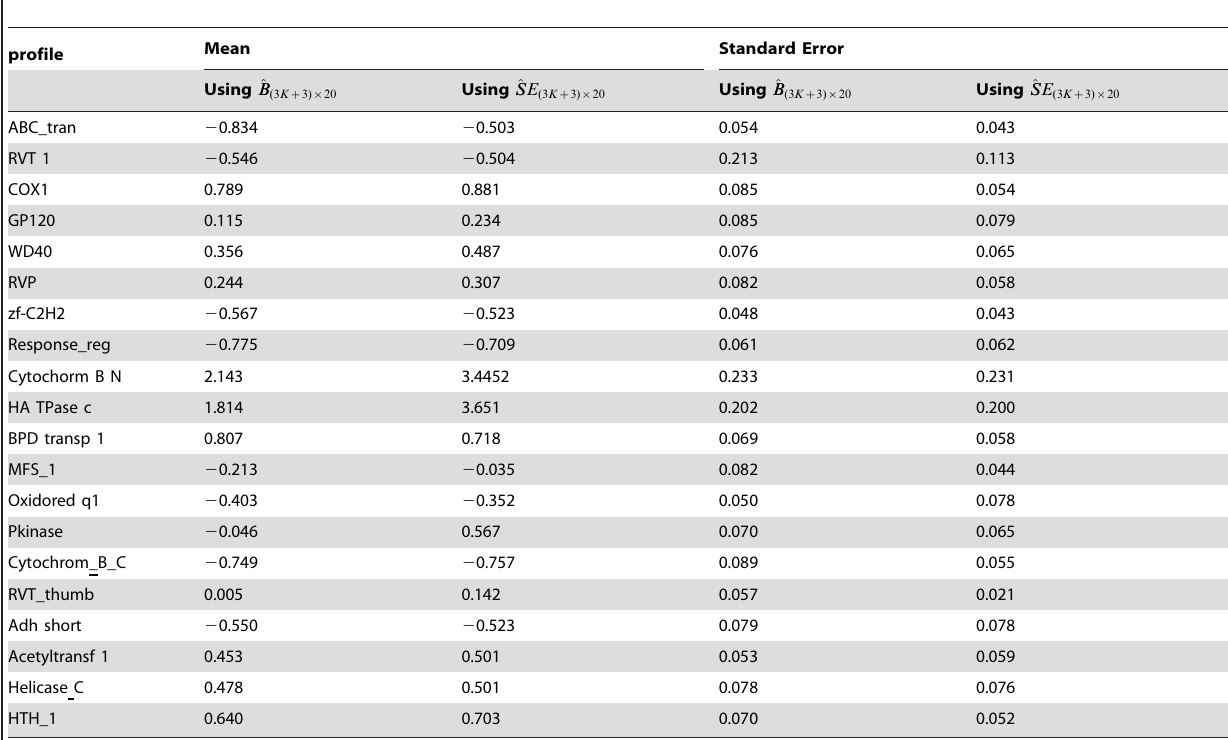
Table 4. The mean and standard error of the standard scores of assigning sequences to each protein family based on the